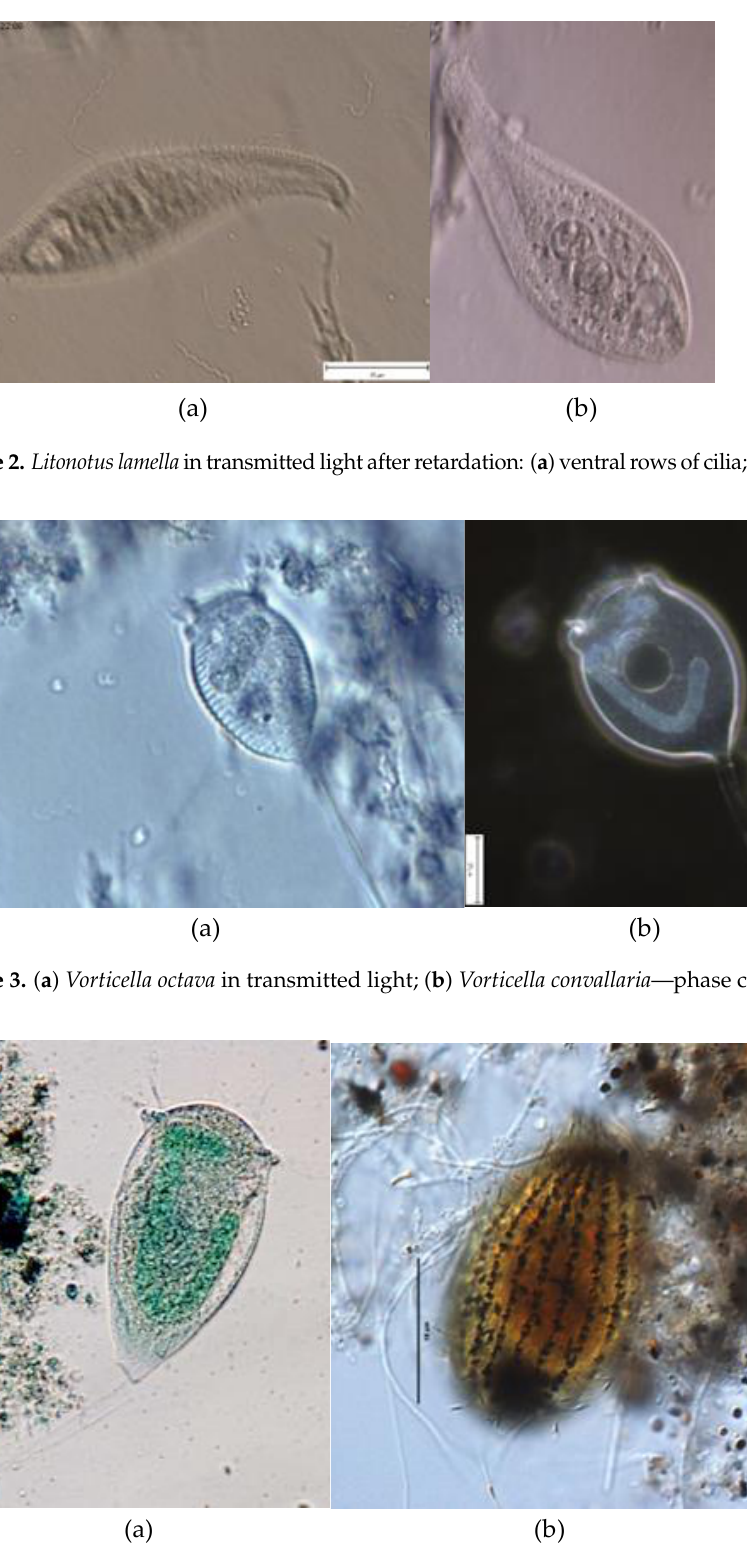
Figure 4. ( a ) temporary preparation, macronucleus of Vorticella convallaria stained with methylene green; ( b ) basal bodies of Plagiocampa rouxi .